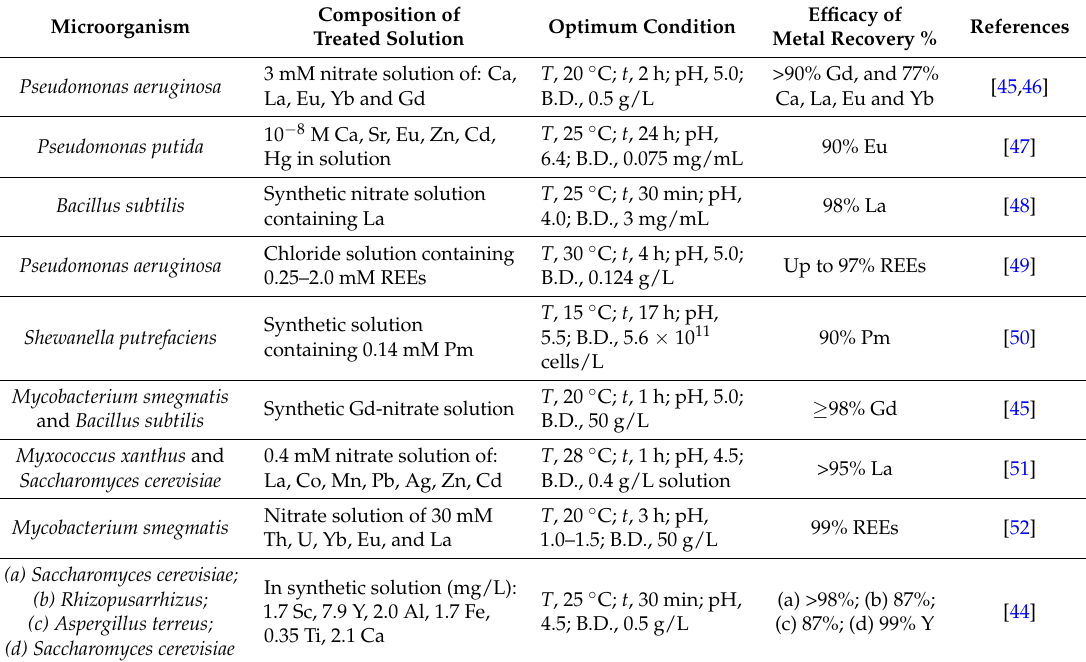
Table 1. A summary of various biosorption processes of rare earth elements ( T = temperature; t = contact time; B.D. = biomass